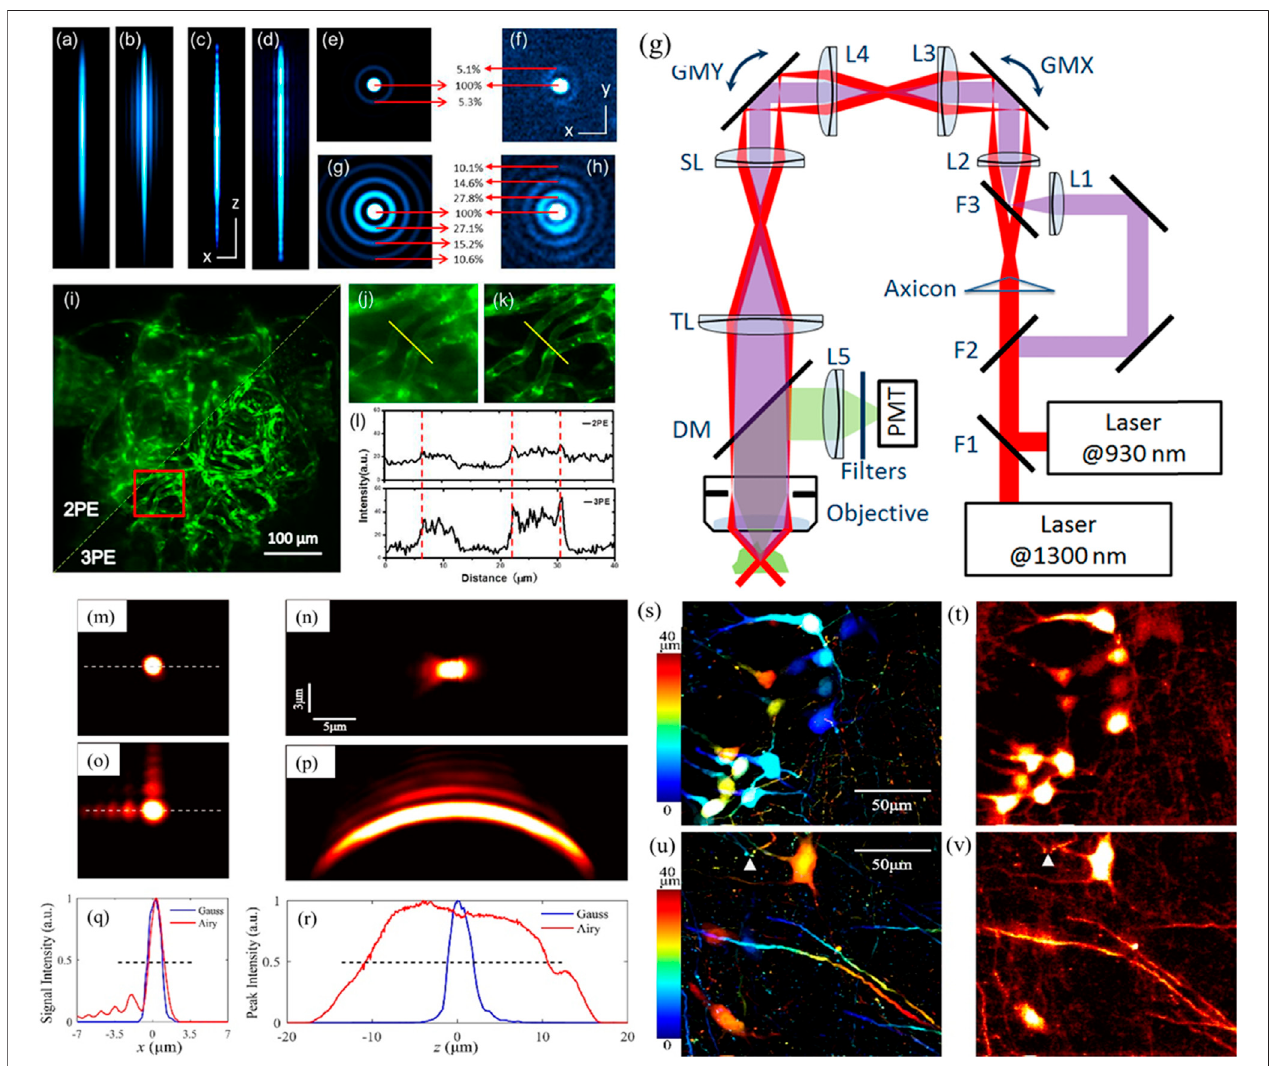
FIGURE 11 |(A,B) Theoretical PSFs of 3PM and 2PM in the x - z plane. (C,D) the experimental PSFs. Scale bars: z , 100 μ m; x , 2 μ m. (E,F) x - y cross-sections from the integration ofthe z -axis of the Bessel beam tosimulate the fl uorescence pro fi le of the side lobes ( E , 3PM; G , 2PM). (F,H) Experimental results. Scale bar, 2 µm. (I – L) Blood vessels in live zebra fi sh under Bessel 3PM and 2PM. (I) An example of the fi sh under Bessel 2PM and 3PM and the region in red box are zoomed in as (J,K) . (L) Fluorescencepro fi lesalongthelineacrossthesamebloodvessels. (G) Schematicdiagramoftheapparatus.F, fl ippermirrors;Axicon, α (cid:2) 2 ° ;L,Lenses;SLandTL (200 mm).Multipleconjugateplaneswerecreatedontothebackfocalplane(BFP)oftheobjective.Galvomirrors:GMX/GMY,forbeamscanninginthe x / y direction.DM, dichroic mirror. Images of 1 μ m fl uorescent sphere under (A,B) Gaussian and (C,D) Airy TPM. The (M) lateral and (N) axial PSFs under Gaussian mode. The lateral (O) and axial (P) PSFs under Airy mode. (Q) Lateral intensity distribution in (M,O) . (R) Maximum intensity with respect to the axial direction for (N,P) . Blue lines, Gaussian beam; red lines, Airy beam. (S,U) Projection of image stack of a mouse brain slice with depth coded by color. Step size: 0.5 μ m. (T,V) Single volumetric frame of mouse brain slice captured with Airy TPM. Reproduced with permission from OSA [24,